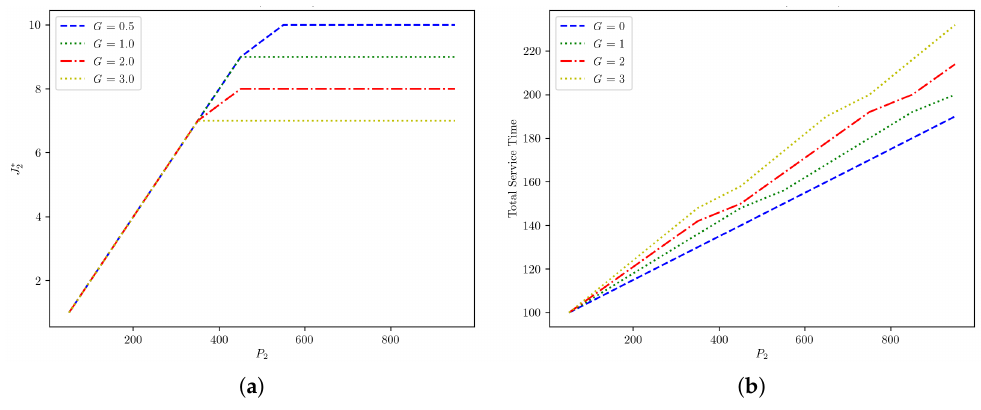
Figure 5. Impacts of change of P 2 with G on J ∗